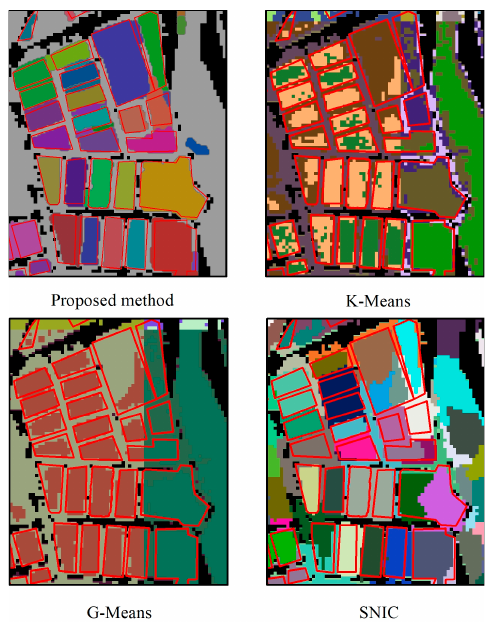
Figure 11. Image segmentation result comparisons among the proposed, K-Means, G-Means, and SNIC methods; the red contours represent the labeled SOAPs. To further evaluate the segmentation accuracy of the proposed method, we overlaid the labeled SOAPs with extracted SOAPs and acquired produced spatially matched SOAP samples on GEE. Similar operations were also conducted between labeled SOAPs and im- age segments from the K-Means, G-Means, and SNIC methods to compare the segmenta- tion accuracy between the proposed method and image segmentation algorithms pro- vided by GEE. We introduced four metrics to verify and compare the segmentation per- formances of the proposed, K-Means, G-Means, and SNIC methods. These five indicators were the root mean squared error (RMSE), mean absolute error (MAE), mean absolute percentage error (MAPE), and mean intersection over union (MIoU), which can be formu- lated as follows: